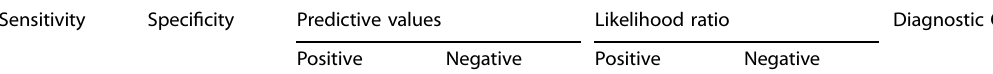
Table 2. Diagnostic measures of the questionnaire items and selected decision